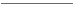
et al. (2003) by comparison of serotype and ST distribution. The largest group (division I) contained 197 isolates, of which 164 were NTHi, 15 were Hia and 18 were Hib, whereas the other group (division II) contained 48 isolates; 12 NTHi, 6 Hie and 30 Hif. Within the two divisions, isolates clustered by serotype and ST. The genetic variation was generally larger among NTHi than among the encapsulated isolates. Overall, 73.3% (11) of the Hia isolates belonged to ST23, 66.7% (12) of Hib to ST6, 83.3% (5) of Hie to ST18 and 86.7% (26) of Hif to